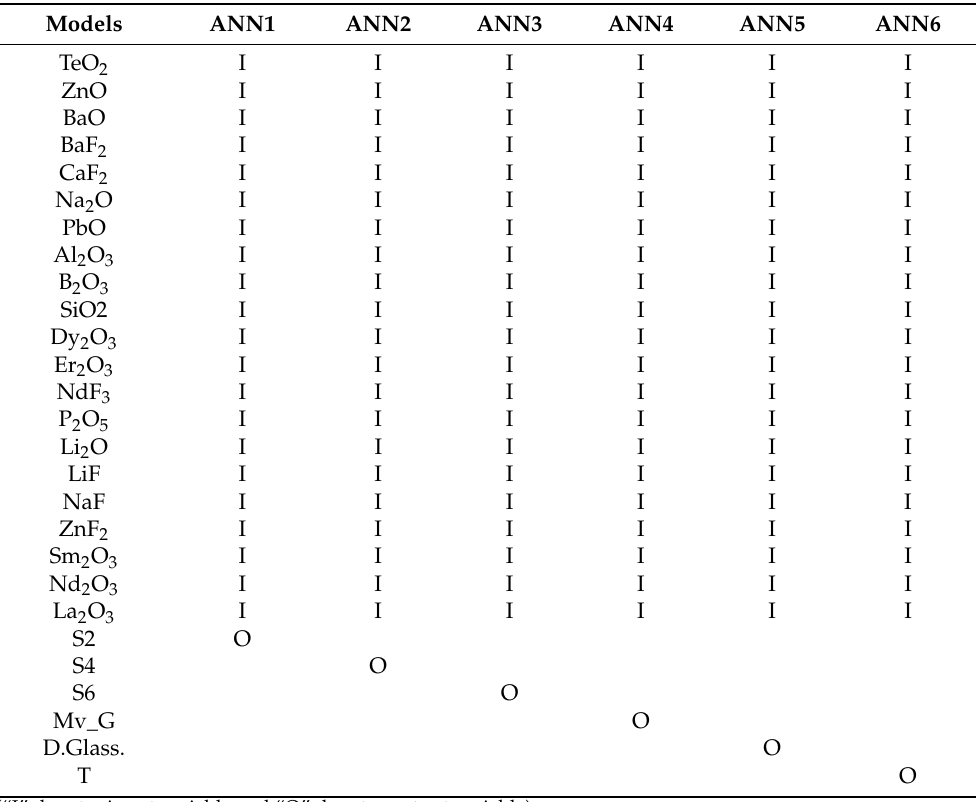
Table 2. Additional key input variables and output variables for all ANN